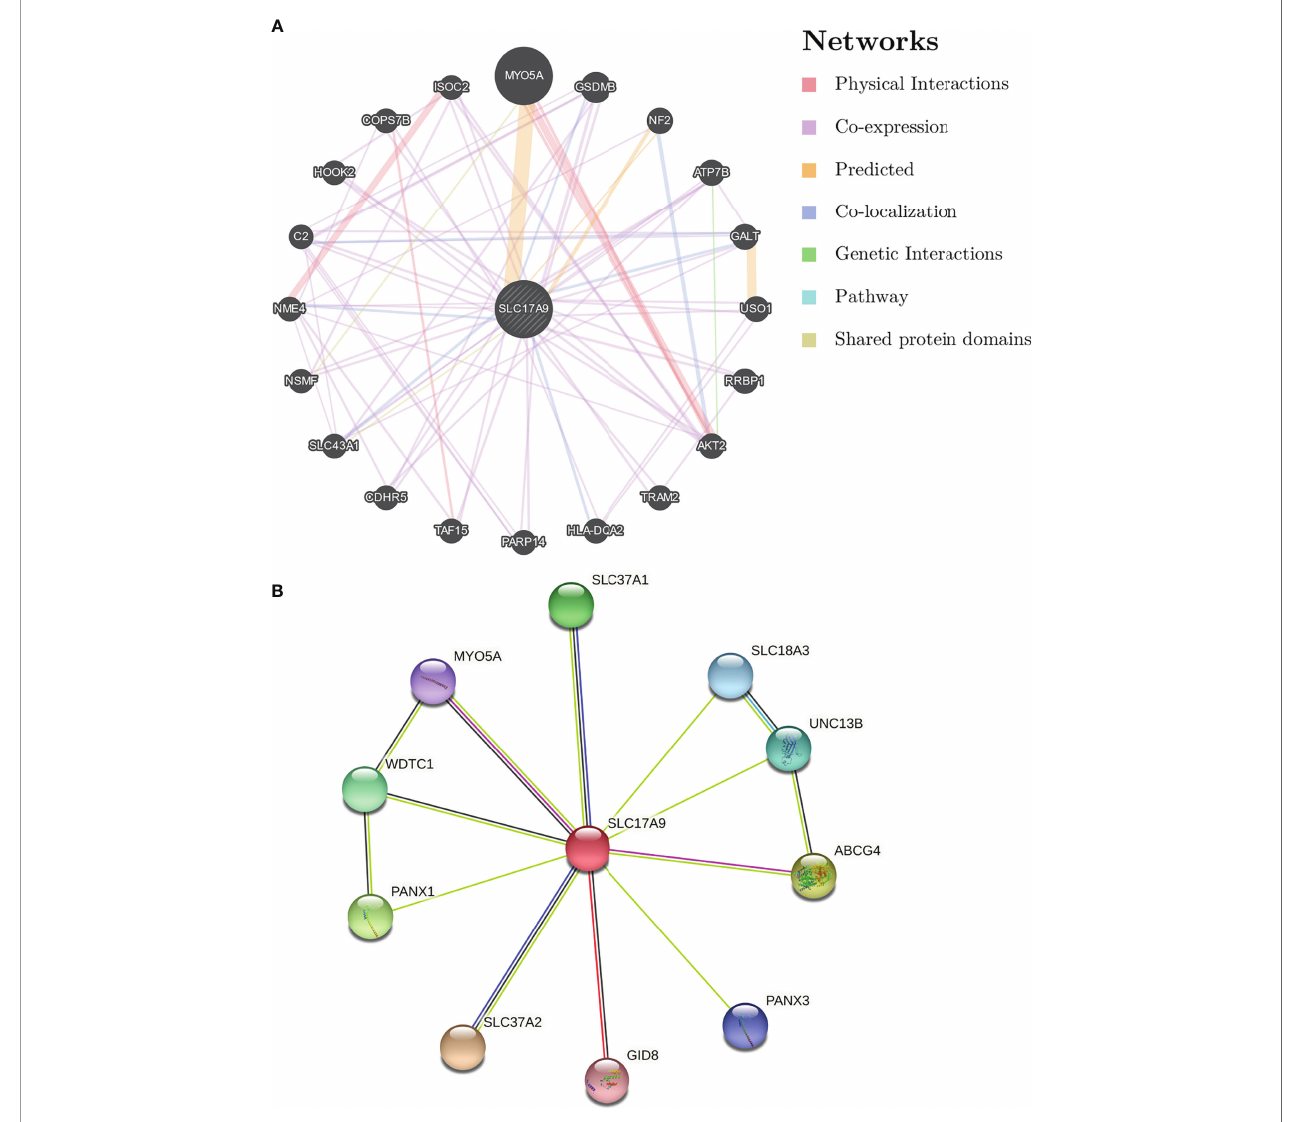
FIGURE 3 | Analysis of gene – gene interaction (GGI) and protein – protein interaction (PPI) of SLC17A9. (A) GGI network of SLC17A9. (B) PPI interaction network of